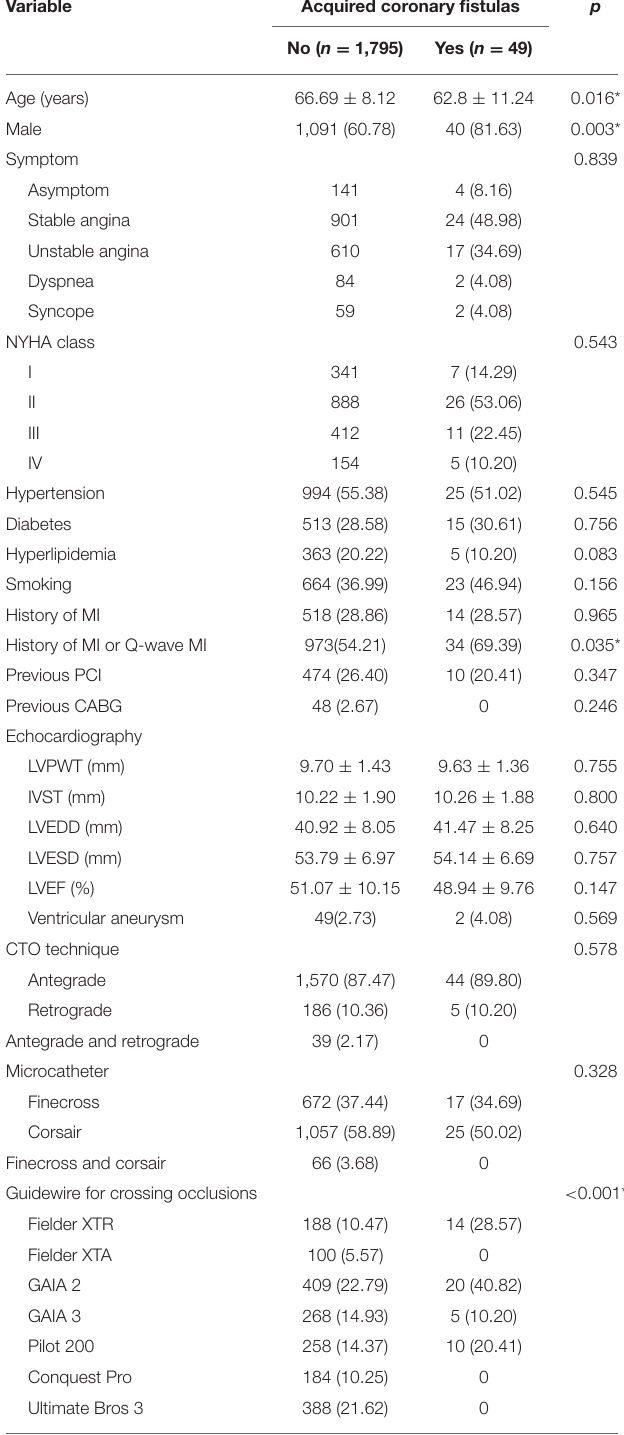
Data are presented as n (%), or mean ± SD. ACFs, acquired coronary fistulas; NYHA, New York Heart Association; MI, myocardial infarction; PCI, percutaneous coronary intervention; CABG, coronary artery bypass surgery; LVPWT, left ventricular posterior wall thickness; IVST, interventricular septum thickness; LVEDD, left ventricular end diastolic diameter; LVESD, left ventricular end systolic diameter; LVEF, left ventricular ejection fraction; CTO, chronic total